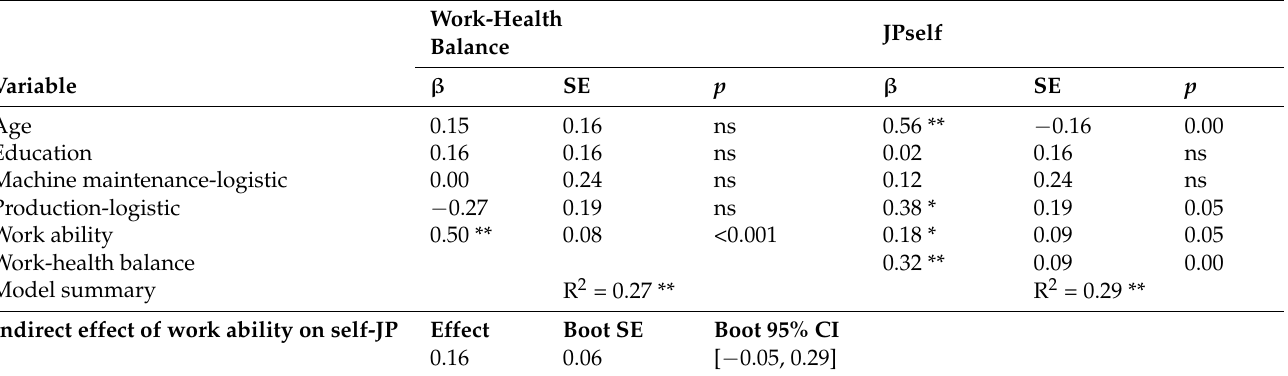
Table 3. Indirect and Direct Associations between Work Ability, Self-Rated Job Performance (JPself) and Work-Health